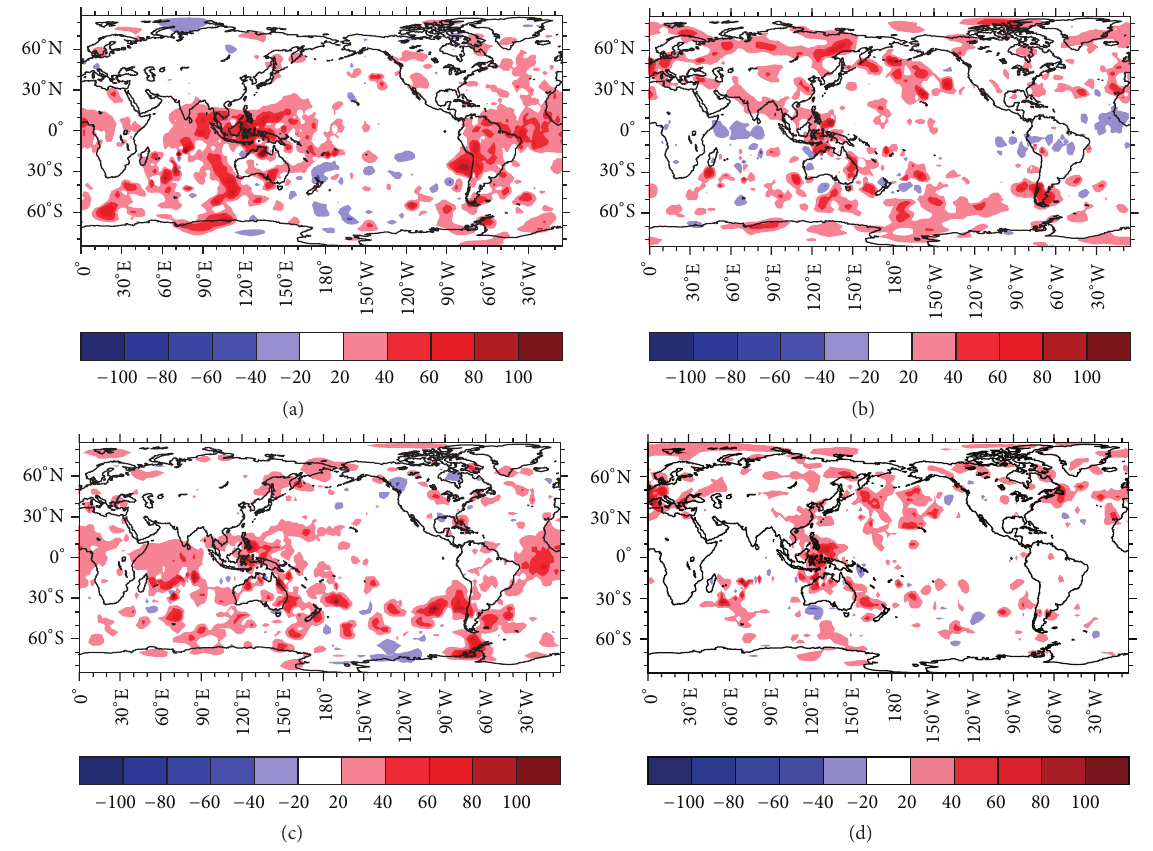
Figure 9: Geographical distribution of 72-hour forecast impact relative to the control forecast on 500 hPa geopotential height in the (a) GSI3DVar-NoAMSU, (b) GSI3DVar-NoRAOB, (c) 3DEnsVar-NoRAOB, and (d) 3DEnsVar-NoAMSU experiments. Color contours shown here are in percentage (%). Red (blue) color represents positive (negative) impact of the observations on the